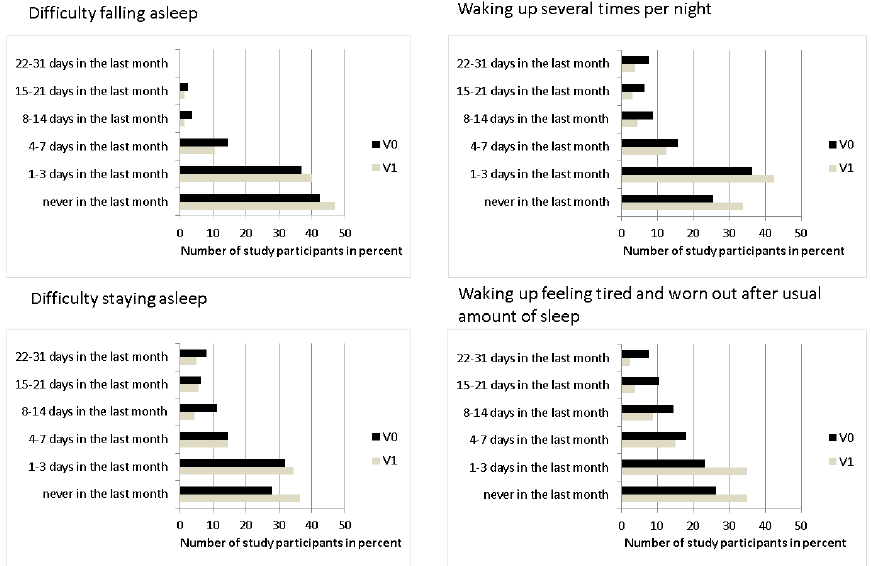
Figure 4. Bar diagrams indicating the percentage of study participants on the x-axis with the different response alternatives according to the Jenkins scale for sleeping behavior on the y-axis before (V0, dark bars) and after iron therapy (V1, bright bars). For all 4 quality of sleep items, there was a statistically significant improvement between V0 and V1 ( p < 0.05 for all, n =